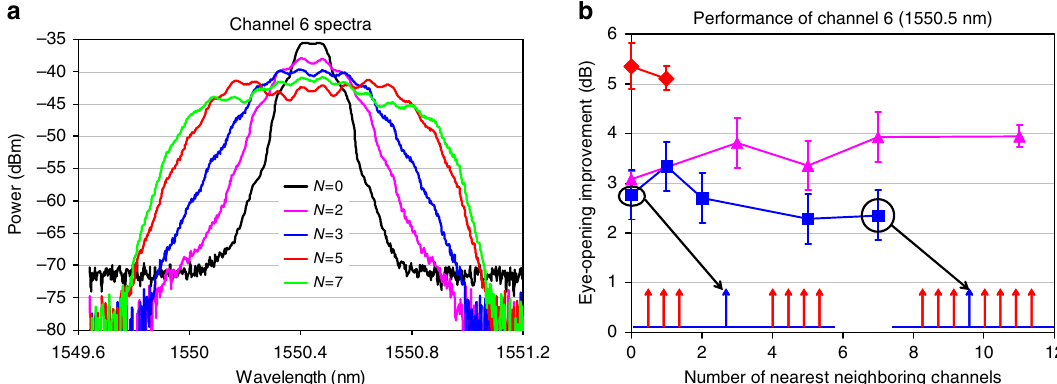
Fig. 3 Multi-channel 2R regeneration in the recirculating loop. a SPM-broadened spectra of the central (1550.5 nm) channel (out of 12 channels total) after N circulations, obtained with the resolution bandwidth of 0.1 nm. b Eye-opening improvement at BER = 10 − 9 for the central 1550.5-nm channel after N = 5 circulations versus the number of other simultaneously regenerated channels. Different-coloured traces in b describe three separate experiments using different EDFAs in the loop and should not be compared to one another. Red diamonds correspond to the increase from 1 to 2 and the purple triangles — to the increase from 1 to 12 in the total number of consecutive 200-GHz-spaced WDM channels. Blue squares correspond to the change in the number of the central channel ’ s closest neighbours on the 200-GHz-spaced grid from 0 to 7, while the total number of channels is kept at 8. Error bars are obtained from the linear fi ts to BER curves ( red diamonds , fi rst and last purple triangles ) and from power measurement uncertainties ( blue squares , three middle purple triangles